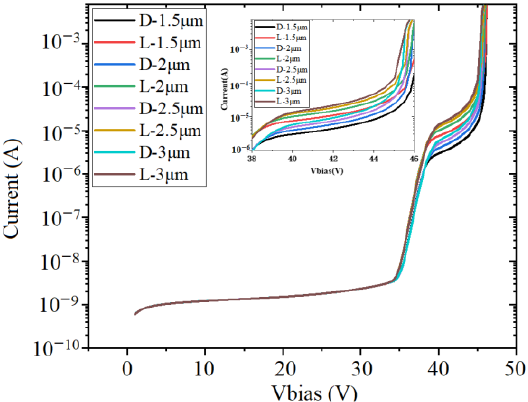
Figure 5. Simulation results of I-V characteristics of devices with different absorption layer thick- nesses (Note. D: dark current; L: light current; the inserted figure is a partial enlargement of Figure 5).